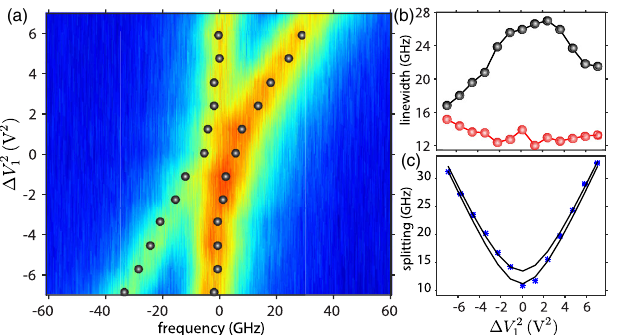
FIG. 5. (a) Fine-tuning scan around the anticrossing point of the measured dispersion curve of Fig. 4(b). Black circles are the resonance frequencies obtained from fitting a double Lorentzian curve to each measured spectrum. (b) Plot of the linewidth versus Δ V 2 1 around the anticrossing point from the double-Lorentzian fit to the measured spectra of (a). Again, black (red) data points correspond to the upper (lower) frequency optical supermode. (c) Plot of the resonance frequency splitting versus Δ V 2 1 . The solid black curves correspond to the fit curves for the 95% confidence interval of the fit value of the tunneling rate, 2 J= 2 π ¼ 12 . 2 (cid:3) 1 . 1